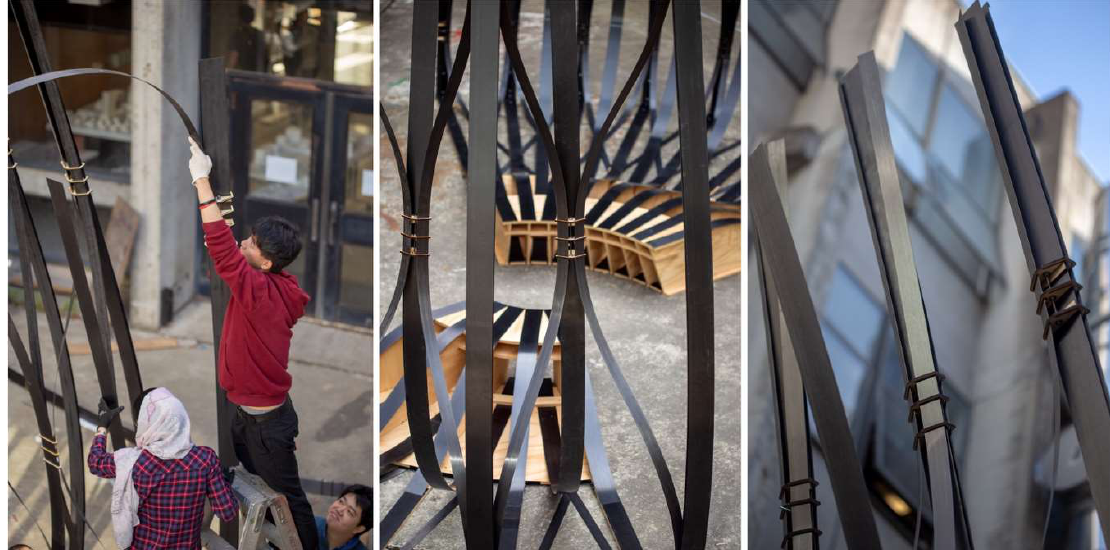
Figure 24. Within two days, the students fabricated and built the 6 m-tall pavilion.